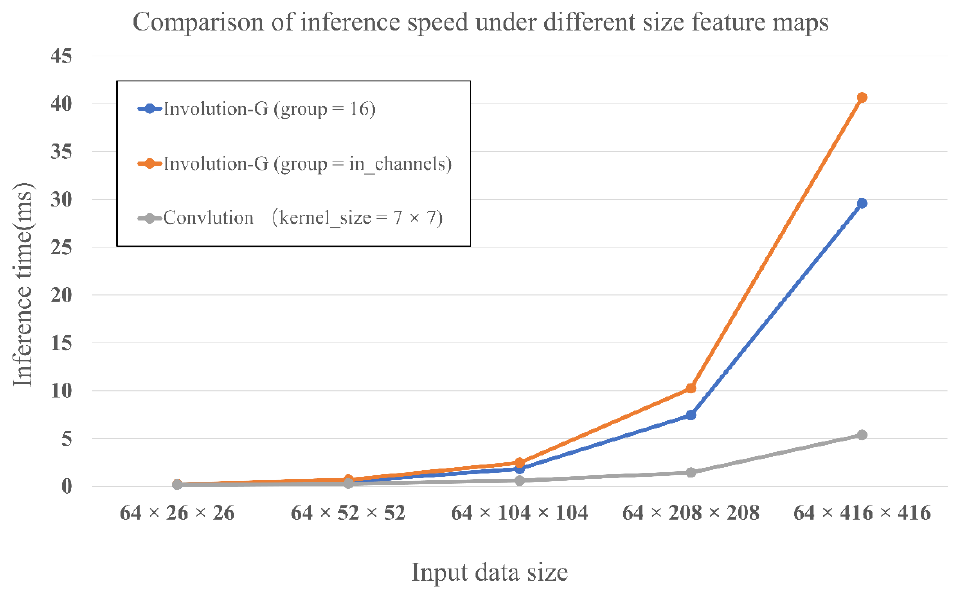
Figure 18. Inference speed of convolution and involution-G operators under different size feature maps with the same number of channels.